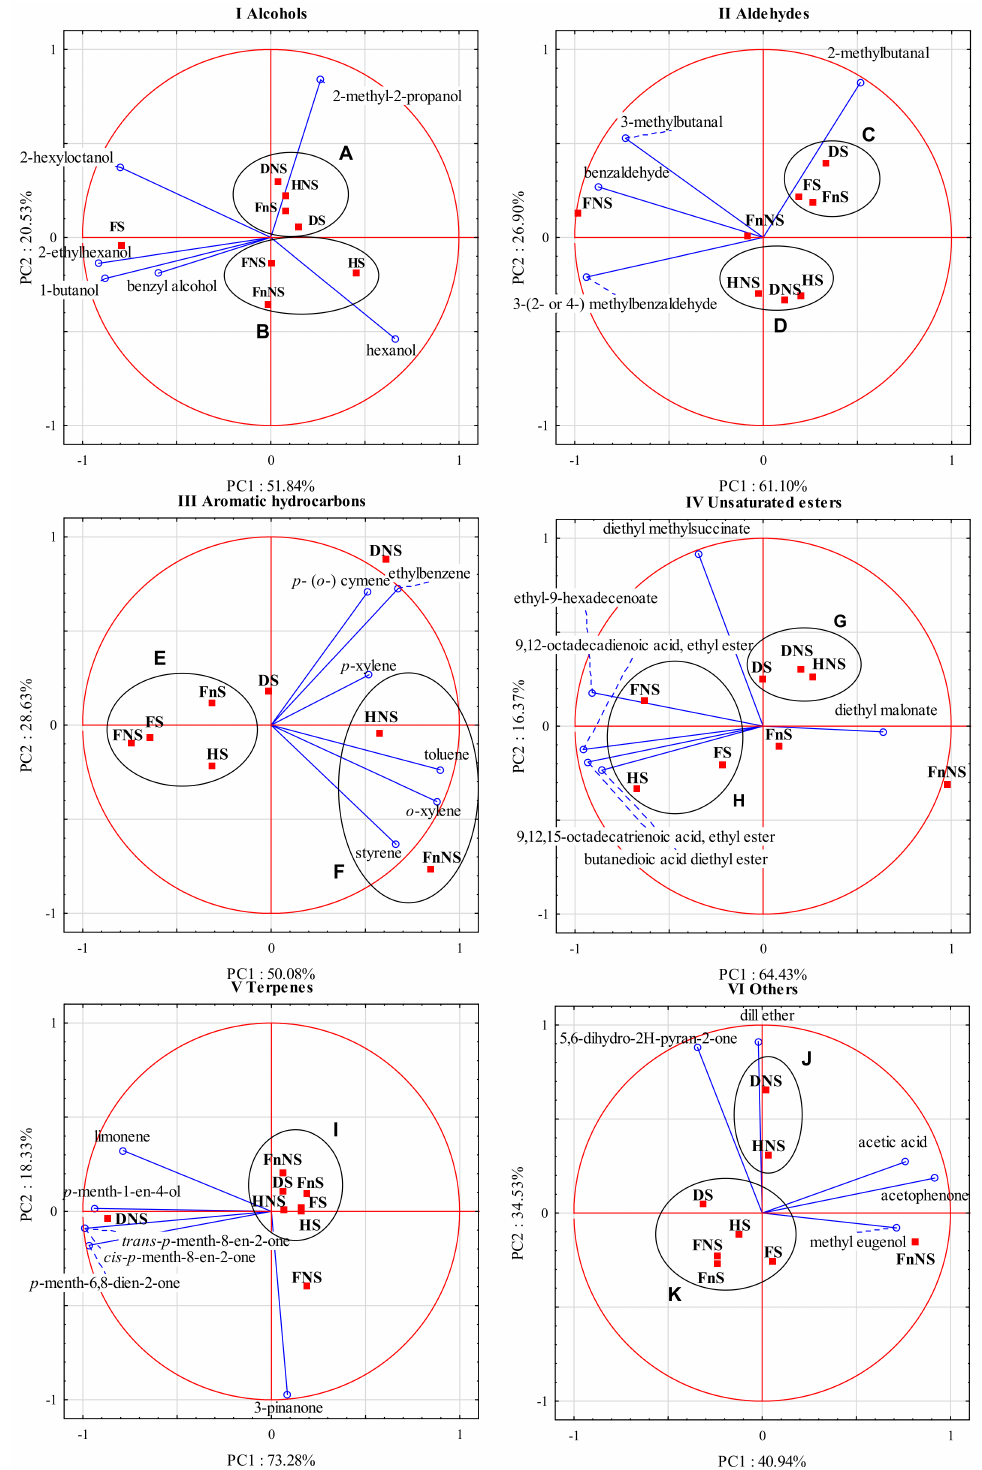
Figure 2. Principal components analysis of the volatile compounds (blue rings) of hawthorn liqueurs (red squares) (PC1 vs. PC2). ( I ) alcohols (groups A and B), ( II ) aldehydes (groups C and D), ( III ) aromatic hydrocarbons (groups E and F), ( IV ) unsaturated esters (groups G and H), ( V ) terpenes (group I), and ( VI ) others (groups J and